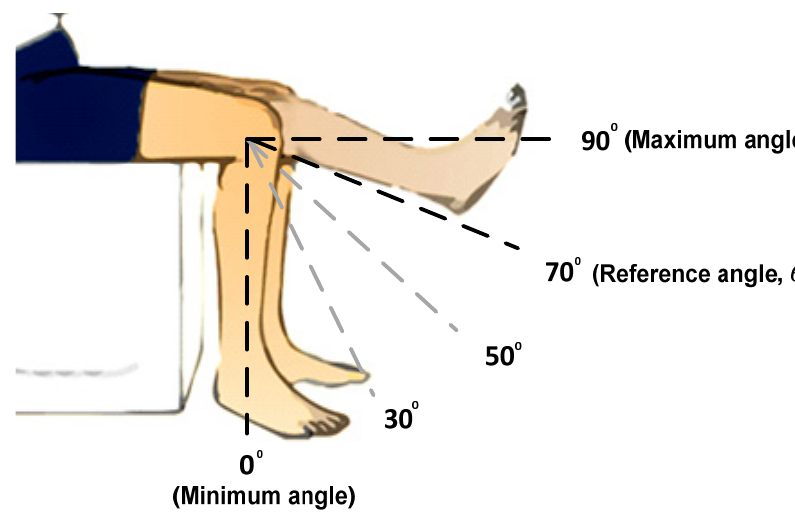
Figure 2. Example of knee extension with a reference angle of 70°.